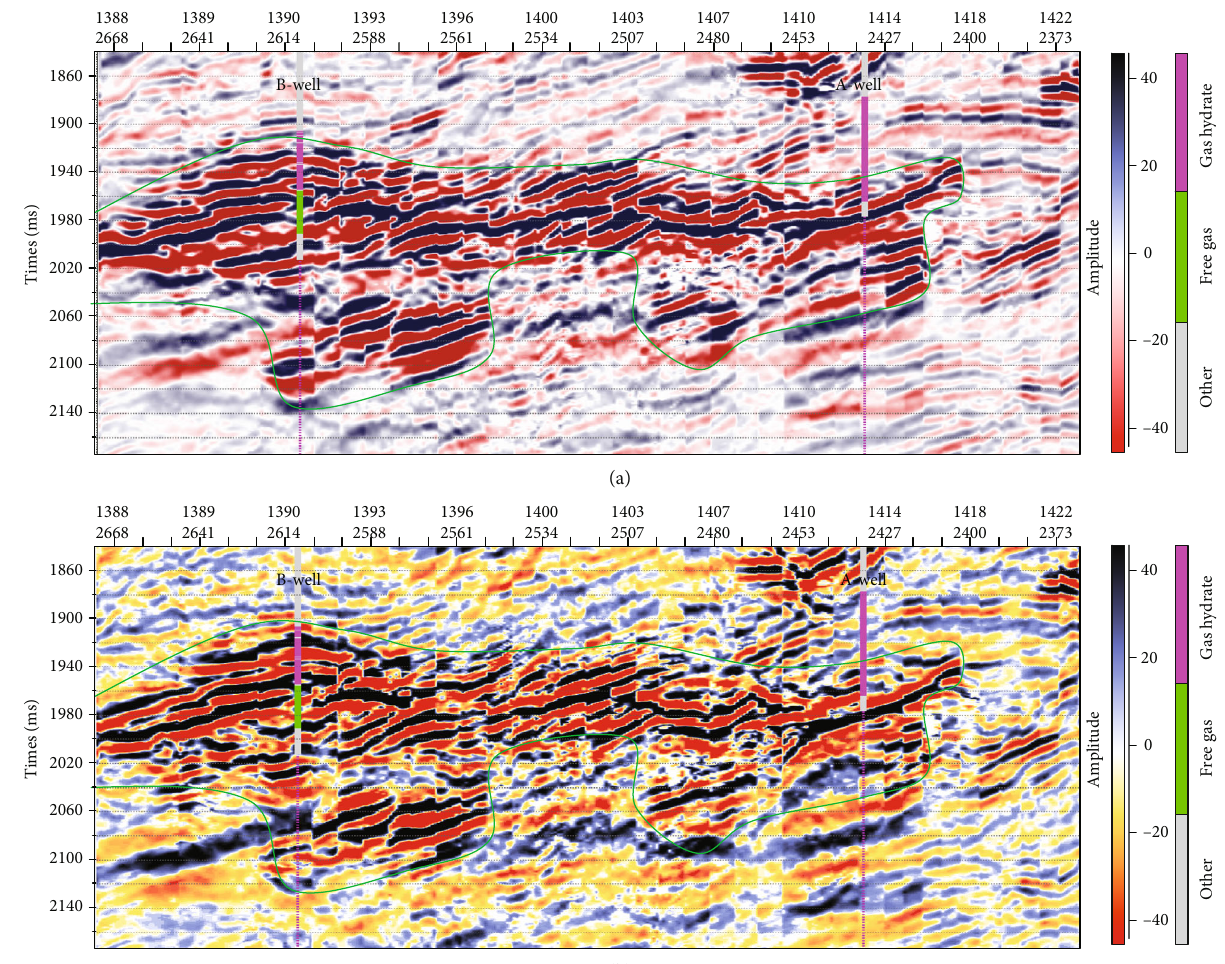
Figure 7: Well-tie AVO intercept and gradient cross section of the A-well and B-well: (a) AVO intercept; (b) AVO